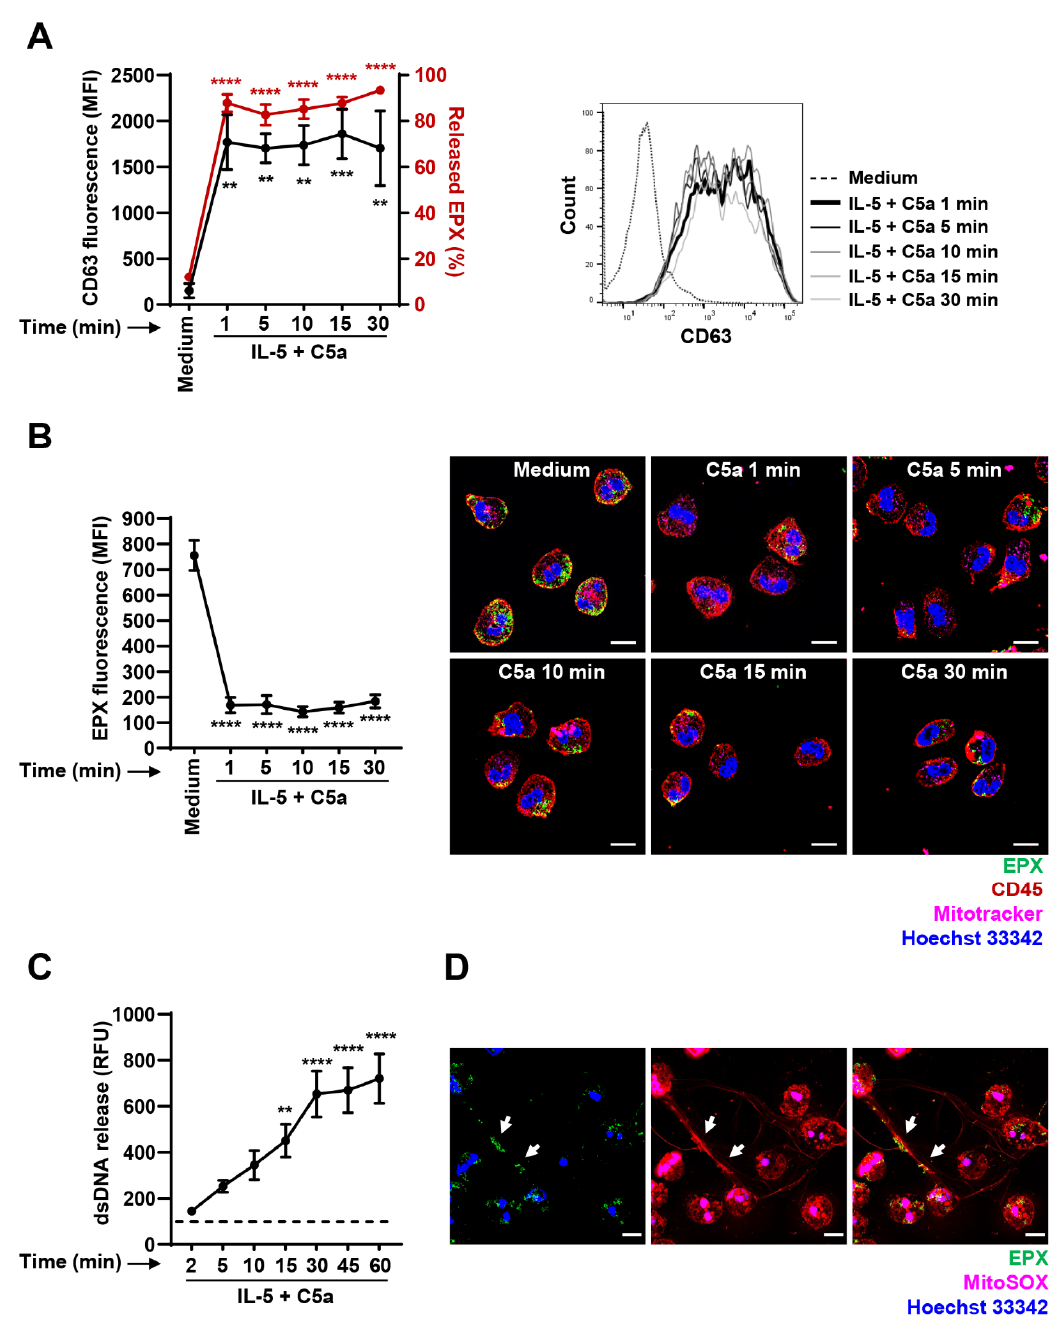
Figure 3. Time-dependent degranulation and extracellular trap (EET) formation by human eosinophils. ( A ) Degranulation assays. Isolated human eosinophils were primed with IL-5 and stimulated with C5a in a time-dependent manner (1–30 min). Eosinophil degranulation was assessed by CD63 surface expression using flow cytometry (black line) ( n = 4) and quantification of released EPX (red line) ( n = 3). Right: A representative histogram of flow cytometry data is shown. ( B ) Confocal microscopy. Freshly isolated human eosinophils were primed with IL-5 and stimulated with C5a for the indicated times (1–30 min). Mitochondria, eosinophil granule protein EPX, plasma membrane and nuclei were stained using Mitotracker Deep Red, monoclonal mouse anti-EPX antibody, monoclonal rabbit anti-CD45 antibody and Hoechst 33342, respectively. Left: Quantification of EPX mean fluorescence intensity (MFI). Cells were delimited using “Surfaces” mode in Imaris followed by the intracellular EPX (green channel) MFI quantification ( n ≥ 11 cells per condition). Right: Representative images of eosinophil degranulation at the indicated time points are shown. Bars, 10 µ m. ( C ) dsDNA release assay. Quantification of released dsDNA in supernatants of activated human eosinophils was assessed using PicoGreen fluorescent dye following the IL-5 priming and C5a activation in a time-dependent manner ( n = 5). The dashed line